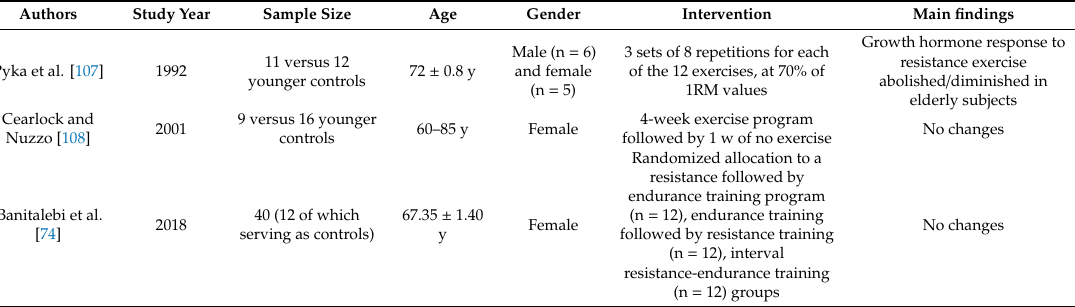
Table 4. Studies investigating the e ff ects of physical activities and exercise on growth hormone in elderly